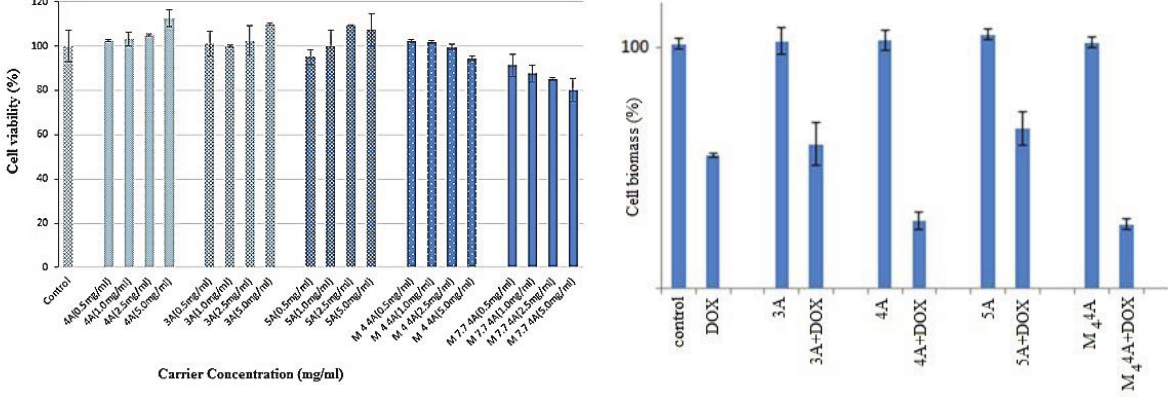
Figure 6: Effect of the different starting zeolites and magnetite form on the SKBr3 cell viability.